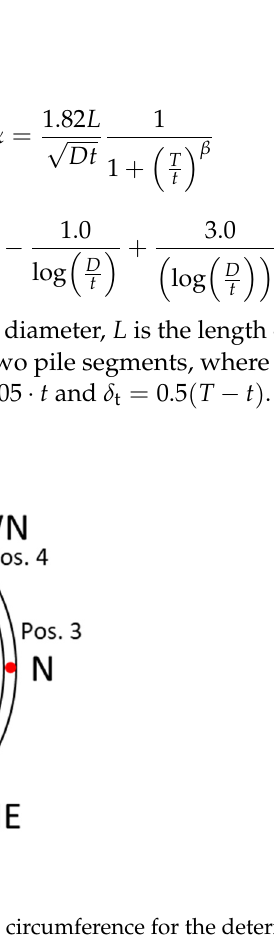
Figure 8. Positions distributed over the circumference for the determination of the stress ranges.